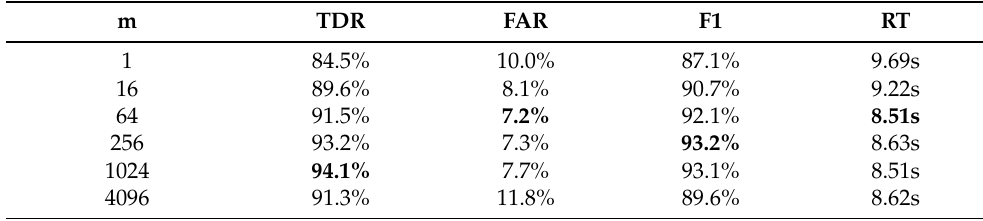
Table 5. The anomaly detection results under different m (scanning period = 4096 and channel width =